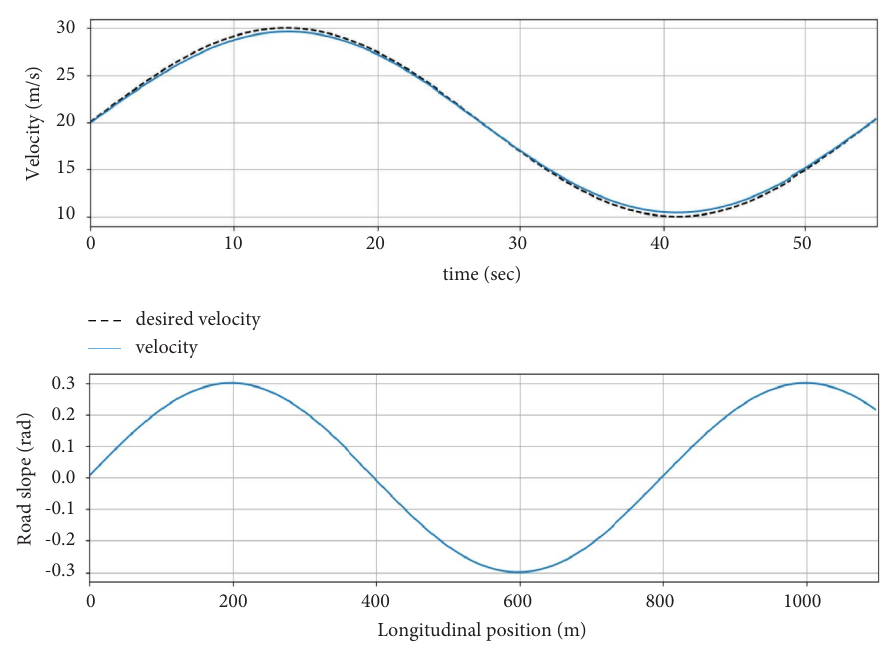
Figure 10: Tracking nonconstant desired velocity on a nonconstant slope